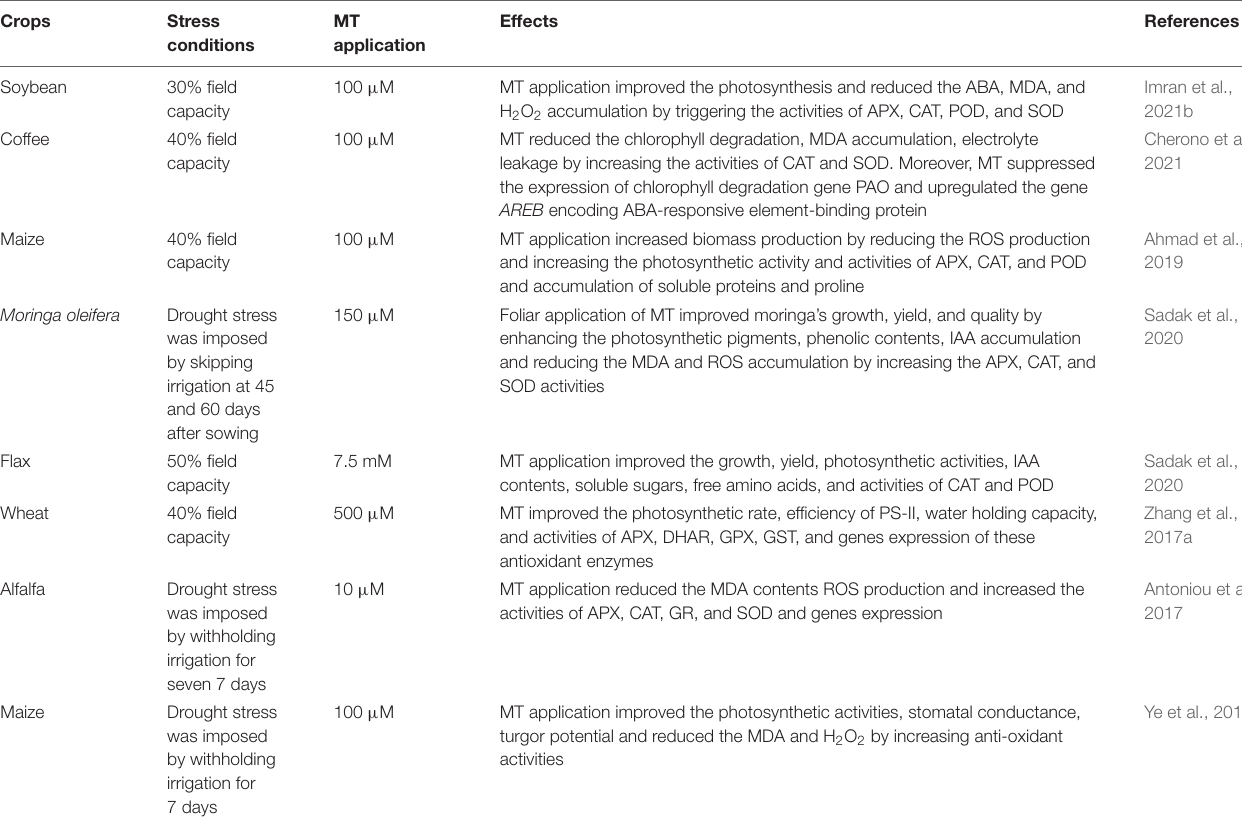
TABLE 2 | Role of melatonin in inducing drought stress tolerance in different plant